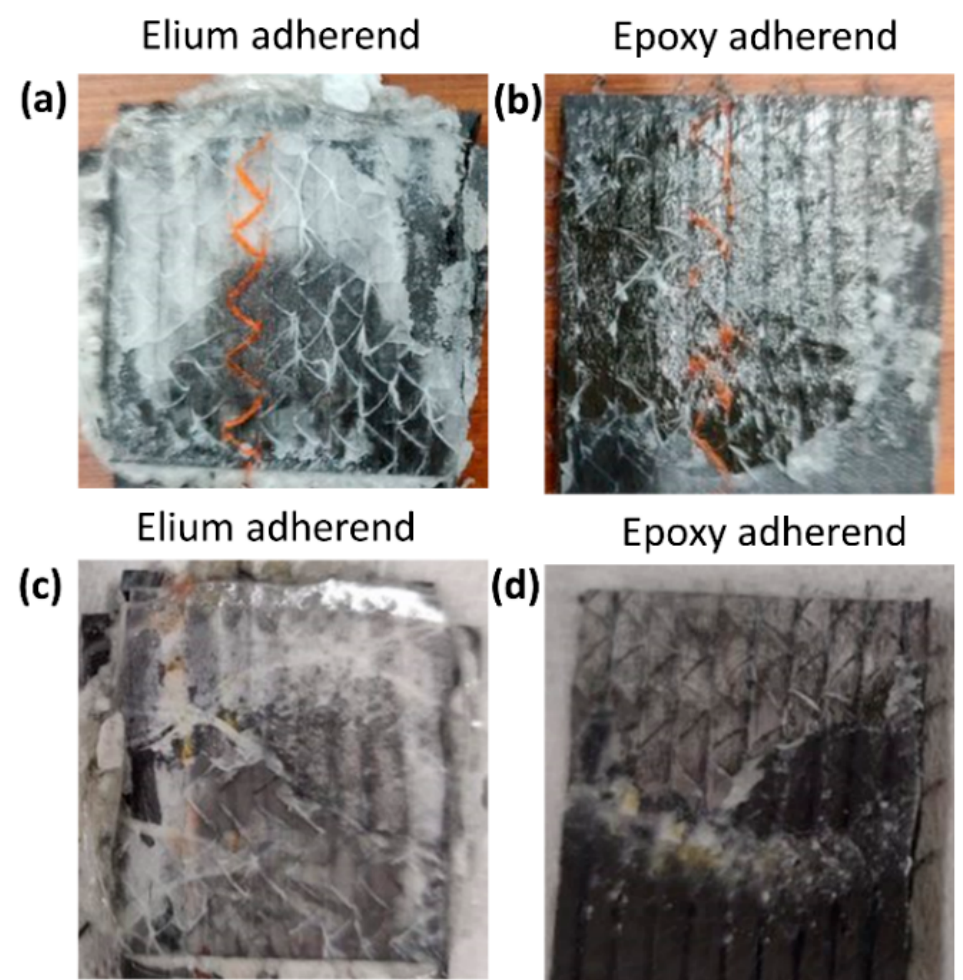
Figure 12. Fracture surfaces of EL-EP(Elium ® - Epoxy)_0.25_0.25 ( a , b ) maximum LSS and ( c , d ) minimum LSS.